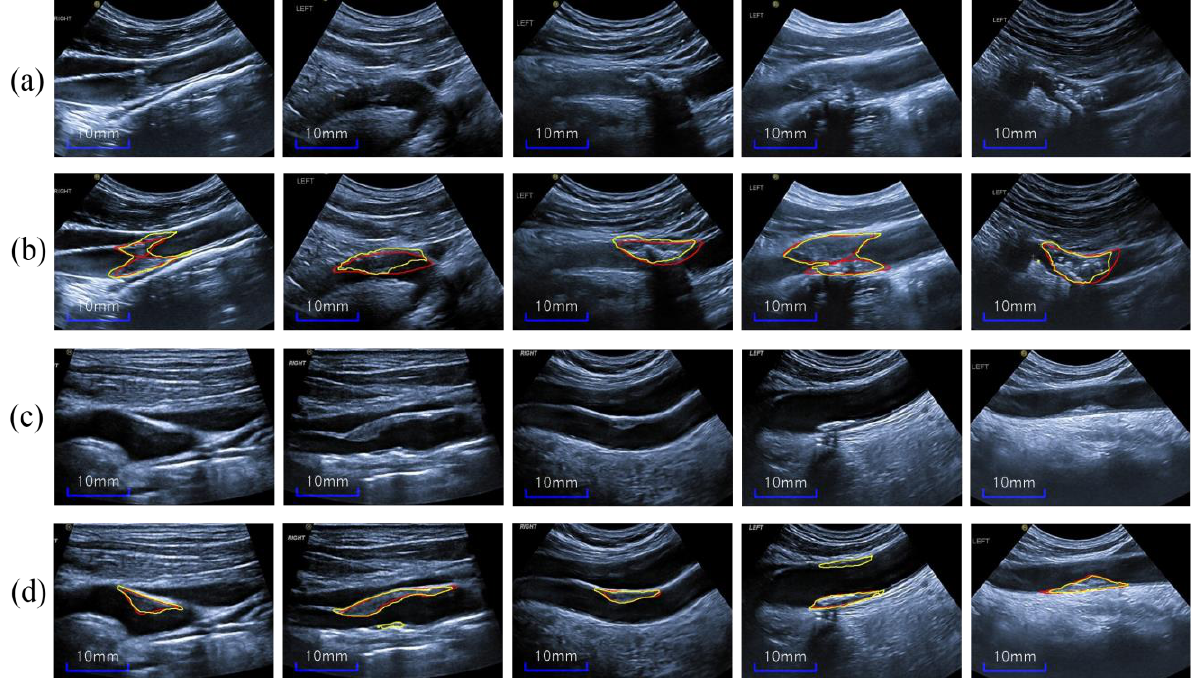
Figure 13. ( a ) and ( b ) show the test results on severe stenotic plaques, ( c ) and ( d ) display the test results on moderate stenotic plaques; the red and yellow outlines superimposed on the input images denote the labels and segmentation result contours.